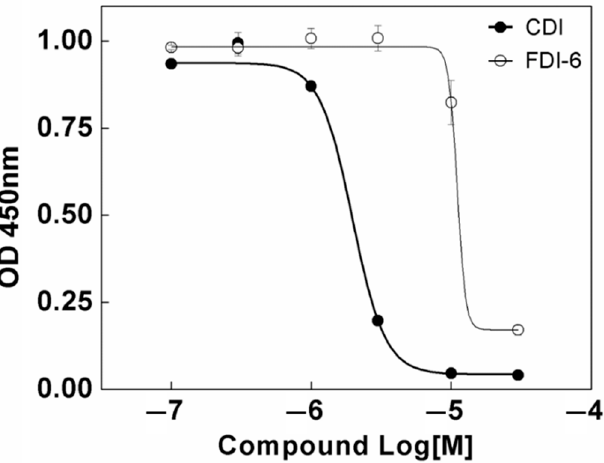
Figure 2. Anti-proliferative effects of CDI ( • ) and FDI-6 ( ◦ ) in MDA-MB-231 cell line. The MDA-MB-231 cells were incubated with 0.1–30 µ M CDI and FDI-6 and were assayed at the 72-h time point using WST cell proliferation reagent. All data are presented as means ± S.D. of three independent experiments.